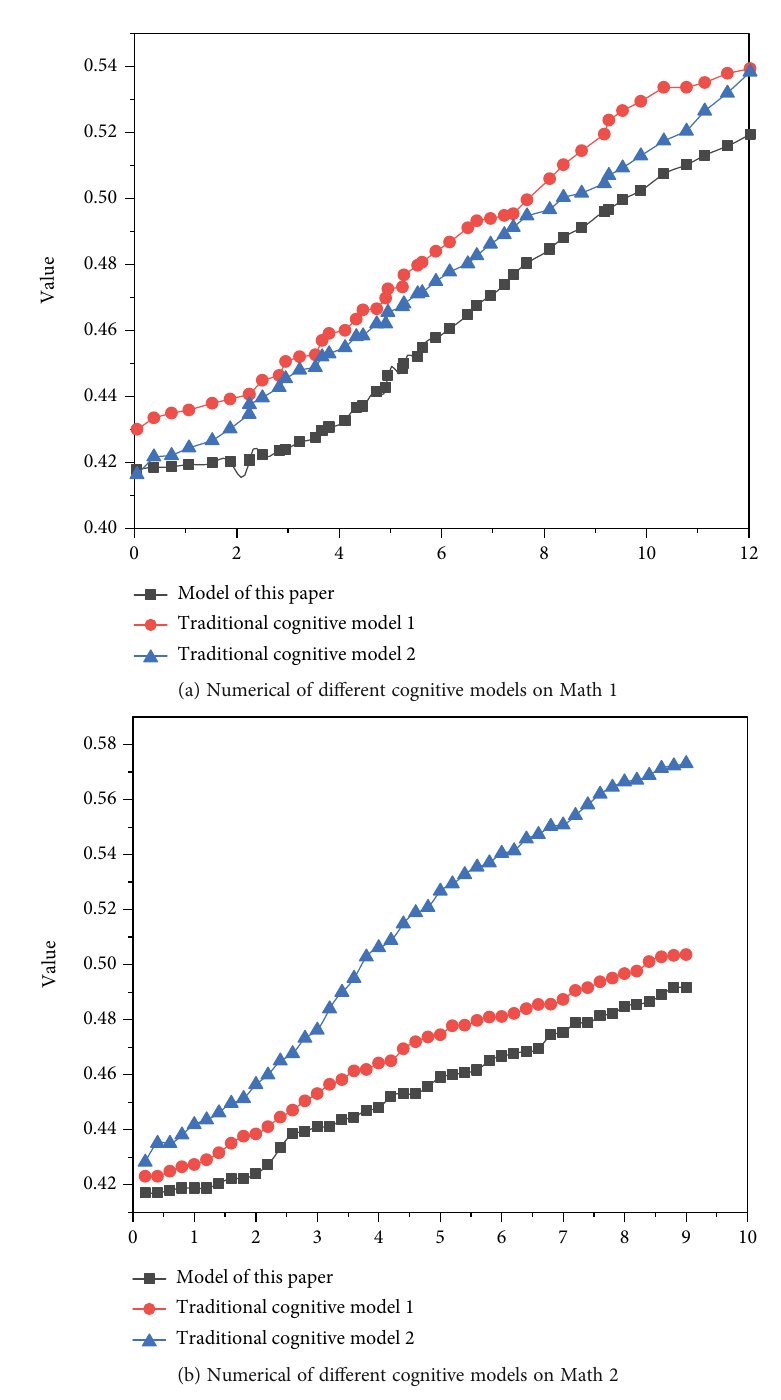
Figure 8: Curves of di ff erent cognitive models on math data